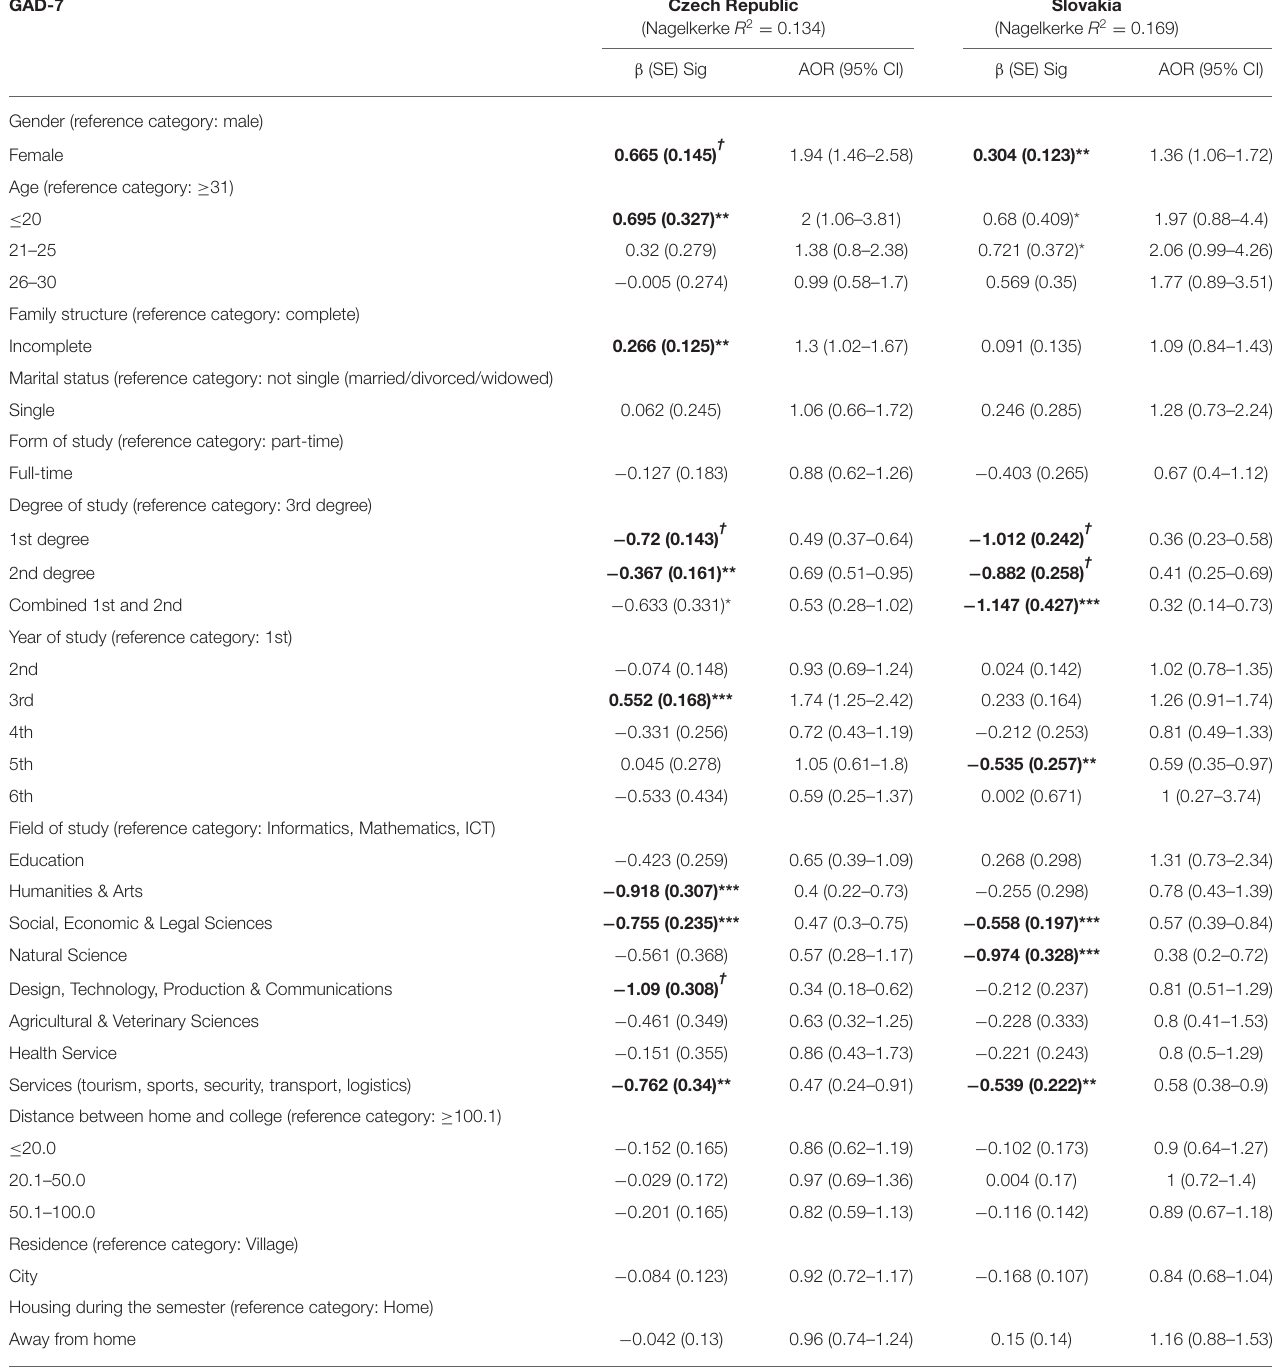
TABLE 4 | Logistic regression analysis with anxiety (GAD-7) as a dependent variable.